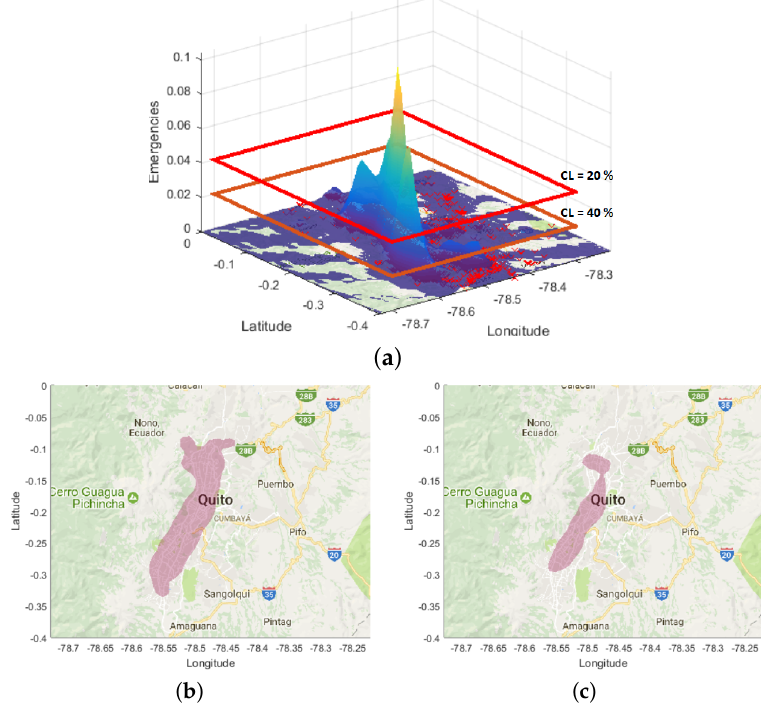
Figure 3. A confidence level (CL) visualization shows the contour that results from the intersection of the Parzen solid representation and the settled horizontal plane, as seen in ( a ); ( b , c ) contour visualization for CL = 40% and CL =